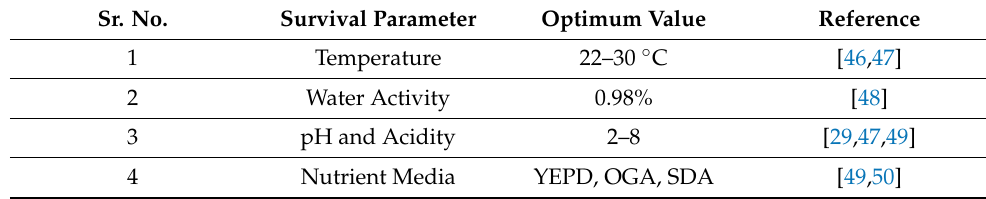
Table 2. Parameters for the survival of S. cerevisiae var. boulardii. Sr. No.